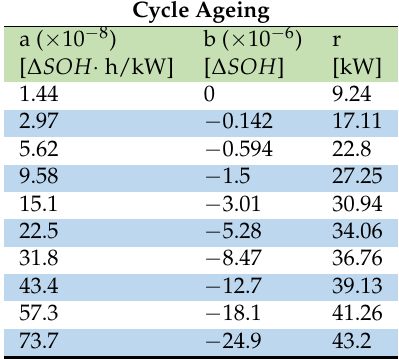
Table A5. PWA approximation parameters for cycle ageing ( r 0 = 0 is